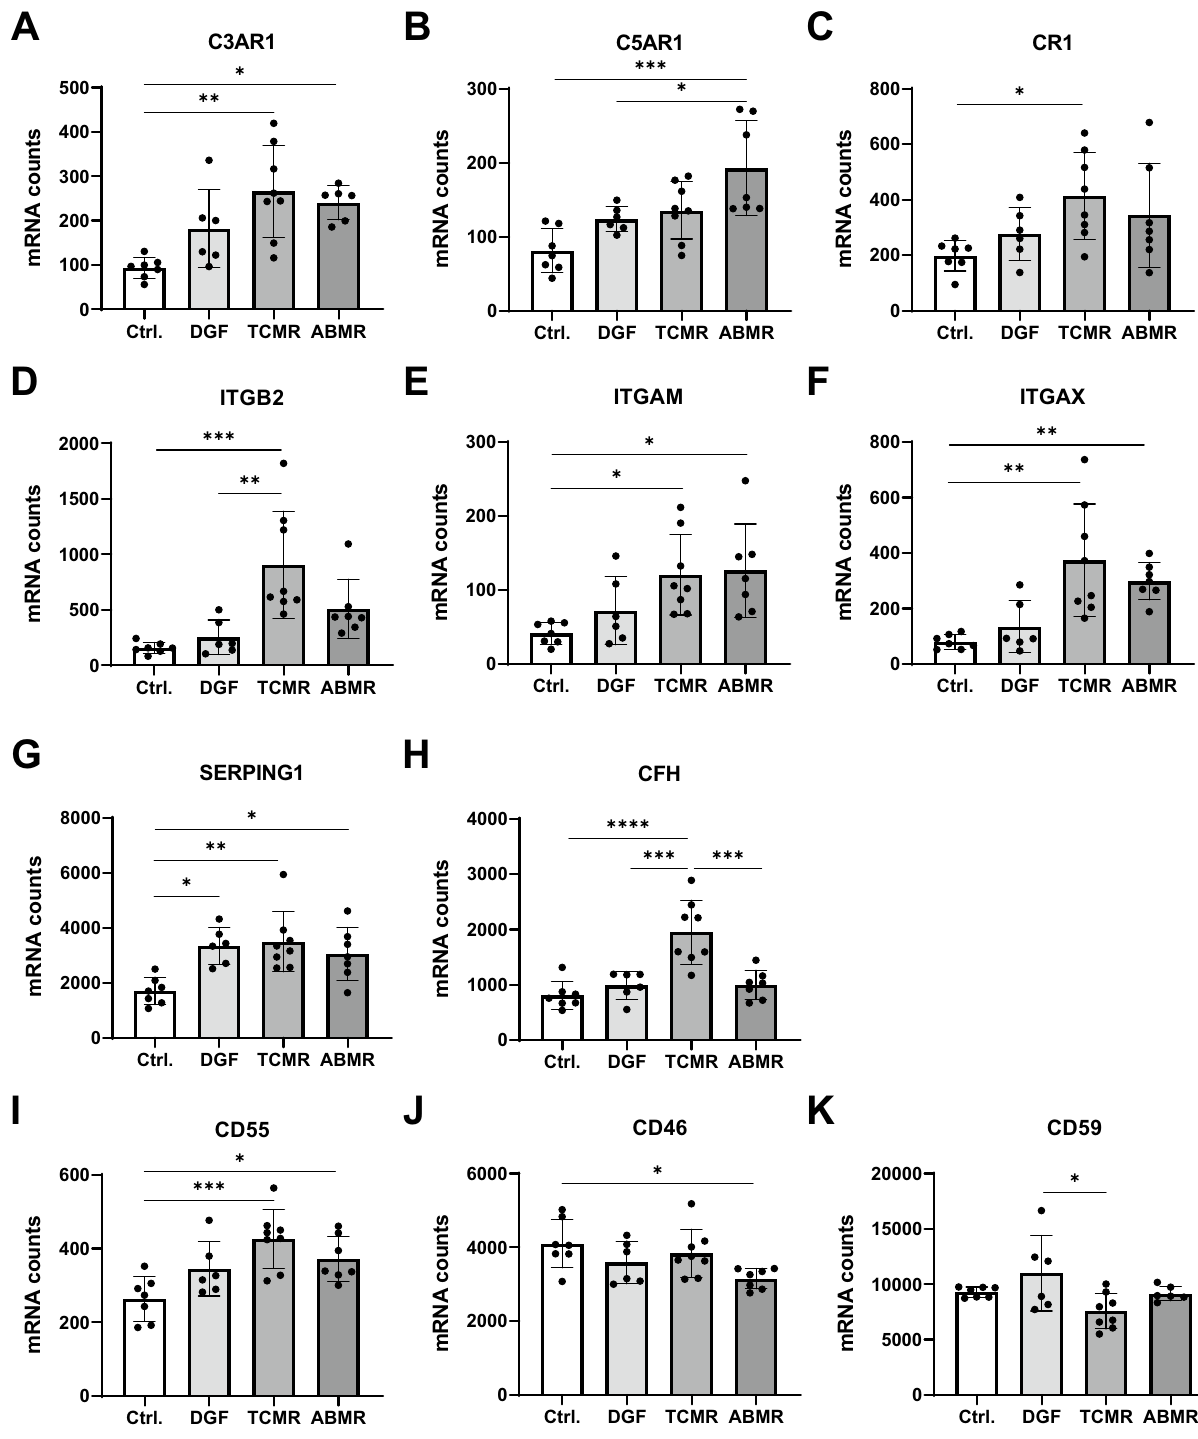
Ctrl. DGF TCMR Figure 2. Expression analysis of complement receptors and complement inhibitors. Number of mRNA molecules coding for the complement receptors C3AR1 ( A , ABMR = 6), C5AR1 ( B ), CR1 ( C ), ITGB2 ( D ), ITGAM ( E ) and ITGAX ( F ) and complement inhibitors SERPING1 ( G ), CFH ( H ) CD55 ( I , ABMR = 6), CD46 ( J ) and CD59 ( K ) in follow-up biopsies of renal transplants with no rejection or dysfunction (Ctrl), delayed graft function (DGF), T-cell mediated rejection (TCMR) or antibody mediated rejection (ABMR); (Statistical analysis: B , C , E , G – K : ANOVA with Tukey’s; A , D , F : Kruskal–Wallis with Dunn’s; *p < 0.05; **p < 0.01; ***p < 0.001; ****p <